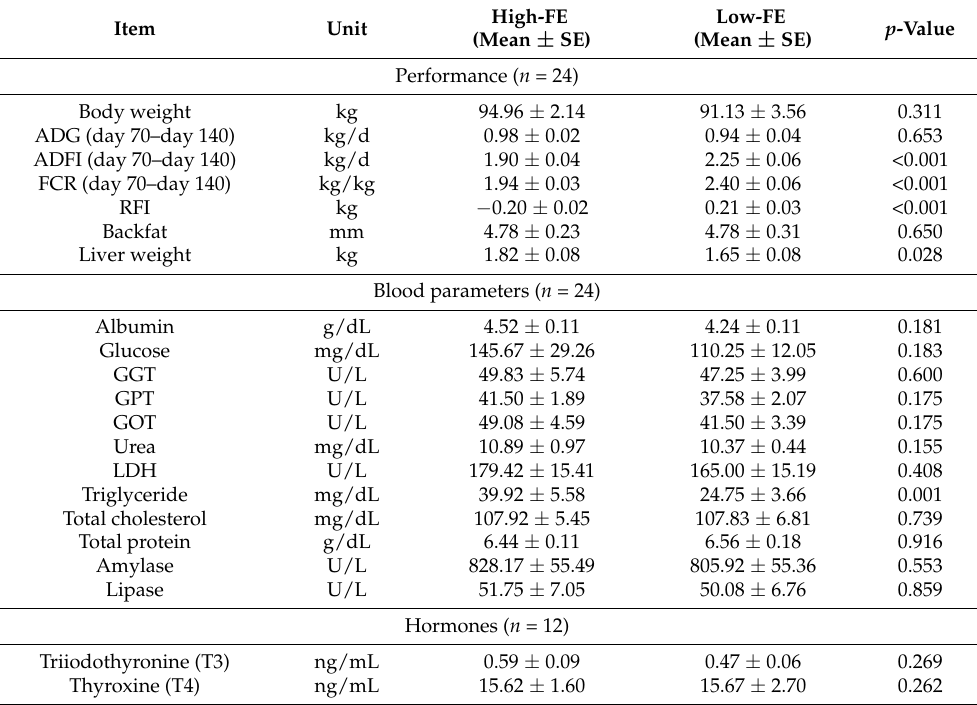
Table 1. Phenotypic records obtained from animals divergent in feed efficiency (FE; measured by residual feed intake) at day 140 of life.